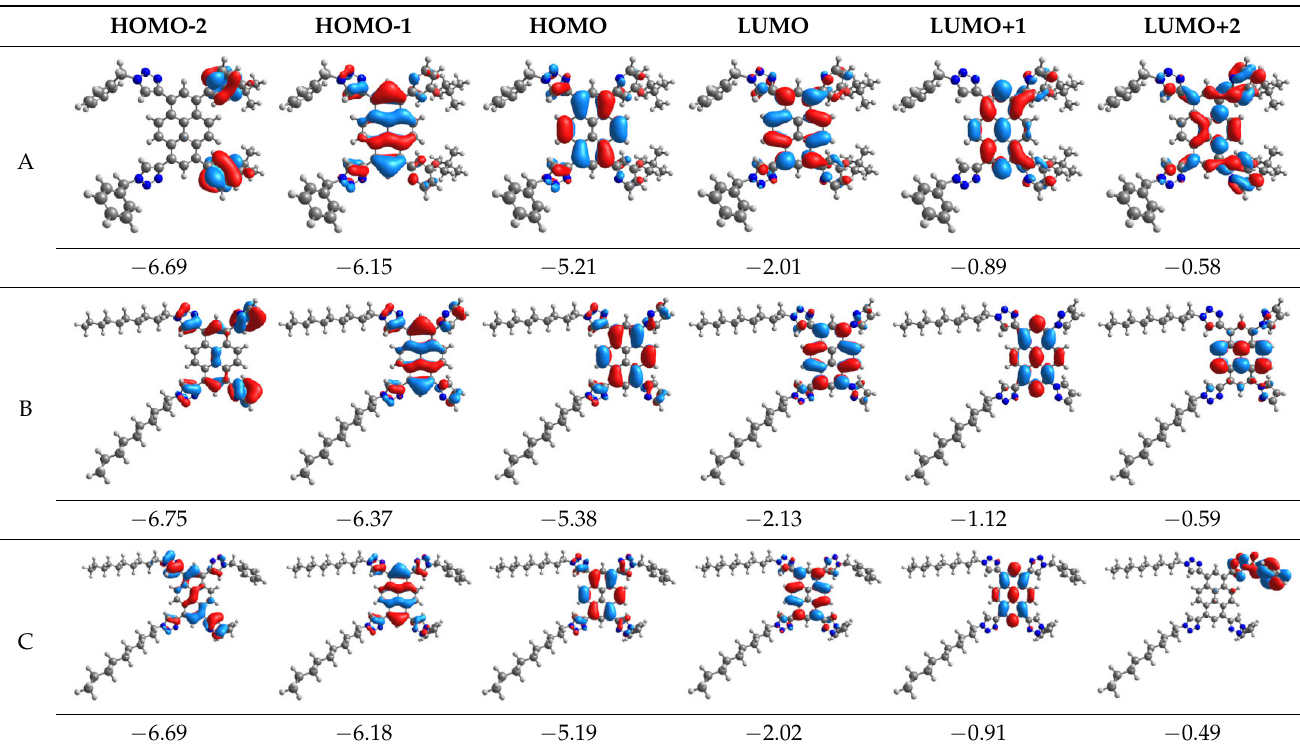
Table 1. Molecular orbitals calculated at the B3LYP/6-31G(d, p) level and their energies in eV for molecules A – C .